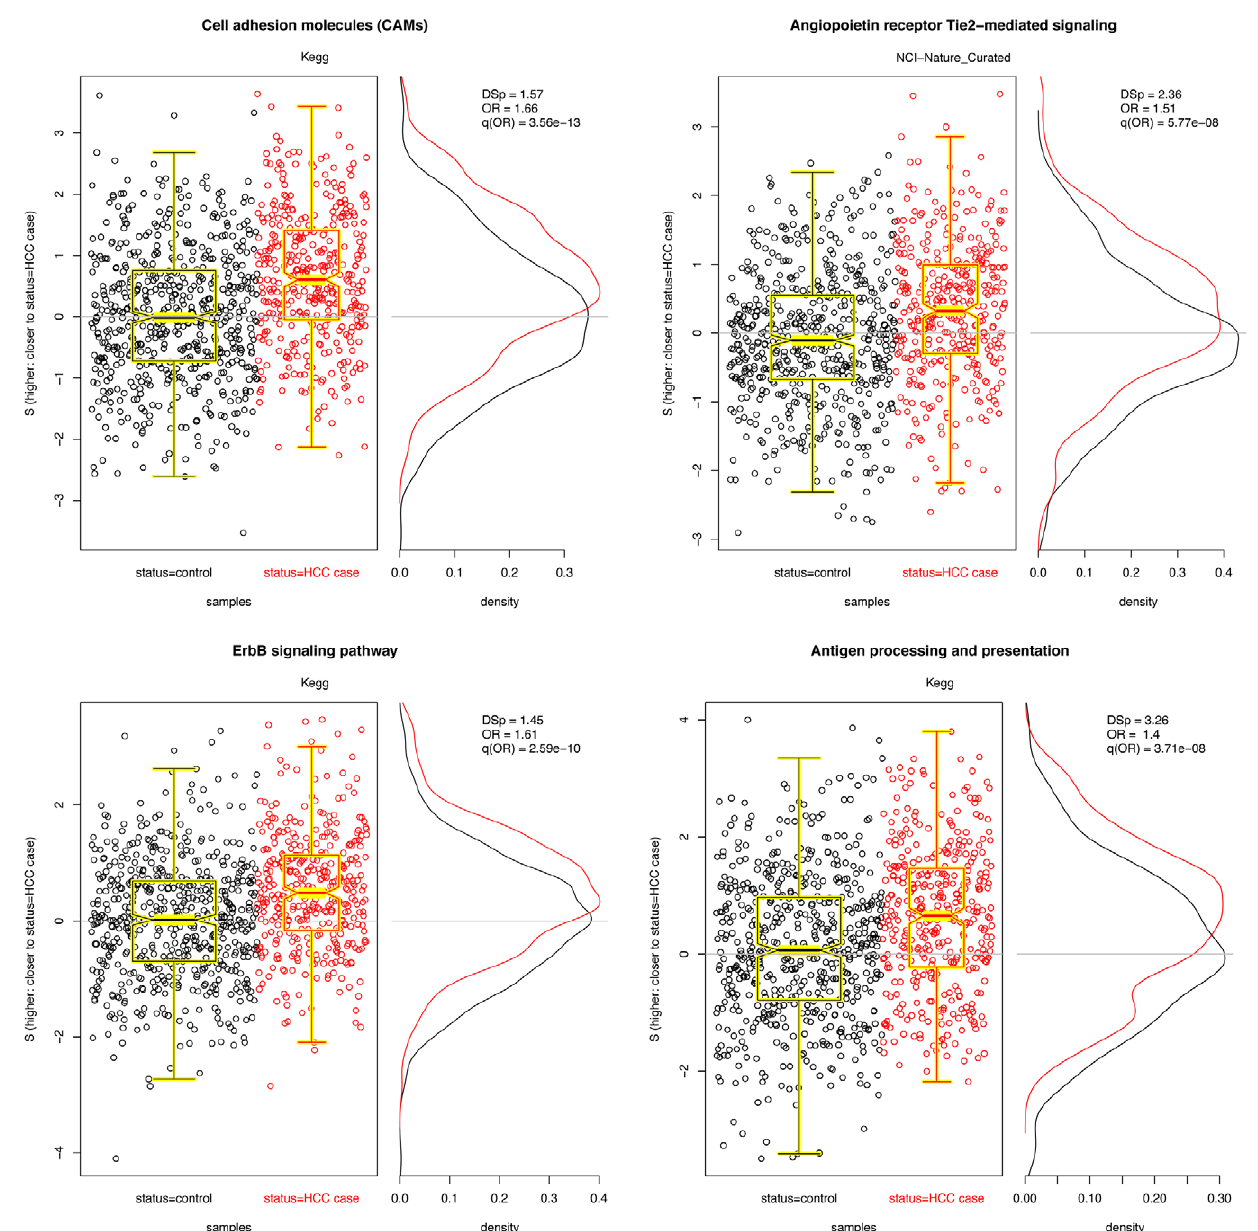
Figure 4. Four significant pathways in liver cancer data. Scatter plots of S Y , P for each pathway are overlayed with boxplots are given in the left panel; higher values of S indicate that the sample is closer to other cases than it is to other controls. Distributions of S for cases (red) and controls (black) are given to the right. A significant shift toward higher S values is seen in the cases. Odds ratios and FDR-adjusted OR p values are given.